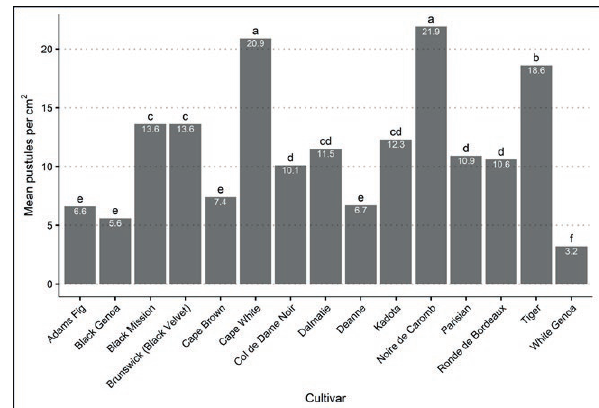
Figure 5. Mean numbers of rust pustules per cm 2 for 15 fig culti- vars after inoculation with Phakopsora nishidana . Mean values, indicated by annotation in the bar, followed by the same letter for each cultivar did not differ (α < 0.05), according to Fishers MSD, where MSD = 2.24 pustules per cm 2